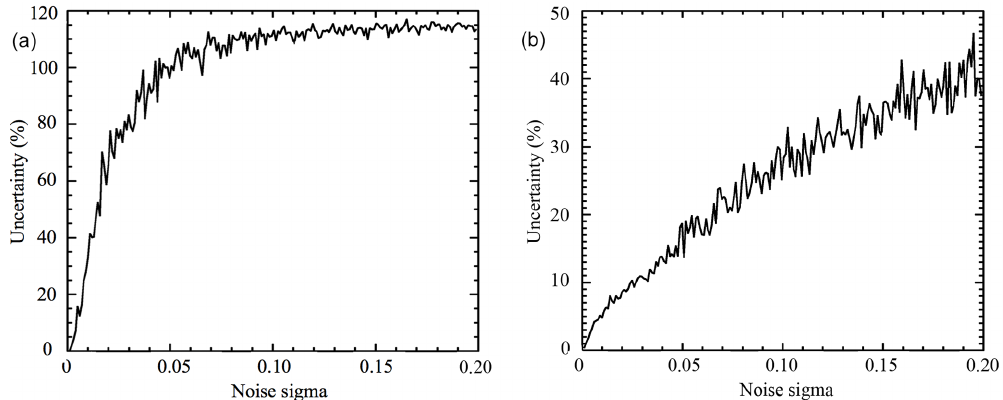
Figure 6. (a) A posteriori uncertainties at 2 σ on the grain diameter as a function of the noise standard deviation, for a 2mm thick ice layer. (b) A posteriori uncertainties at 2 σ on the thickness as a function of the noise standard deviation.